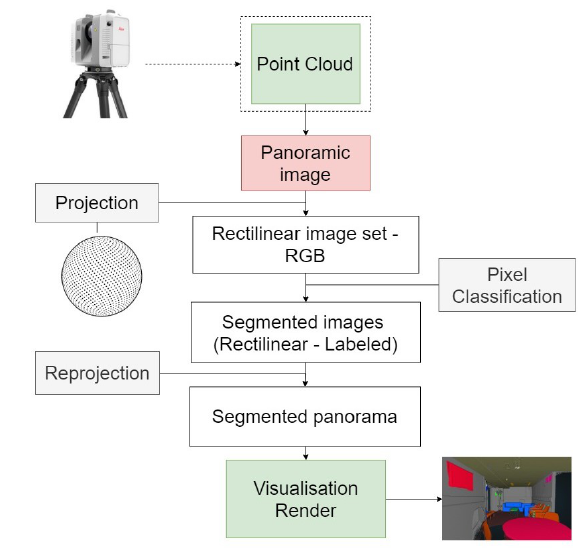
Figure 1. This diagram shows the proposed semantic segmentation process using panoramic images from TLS